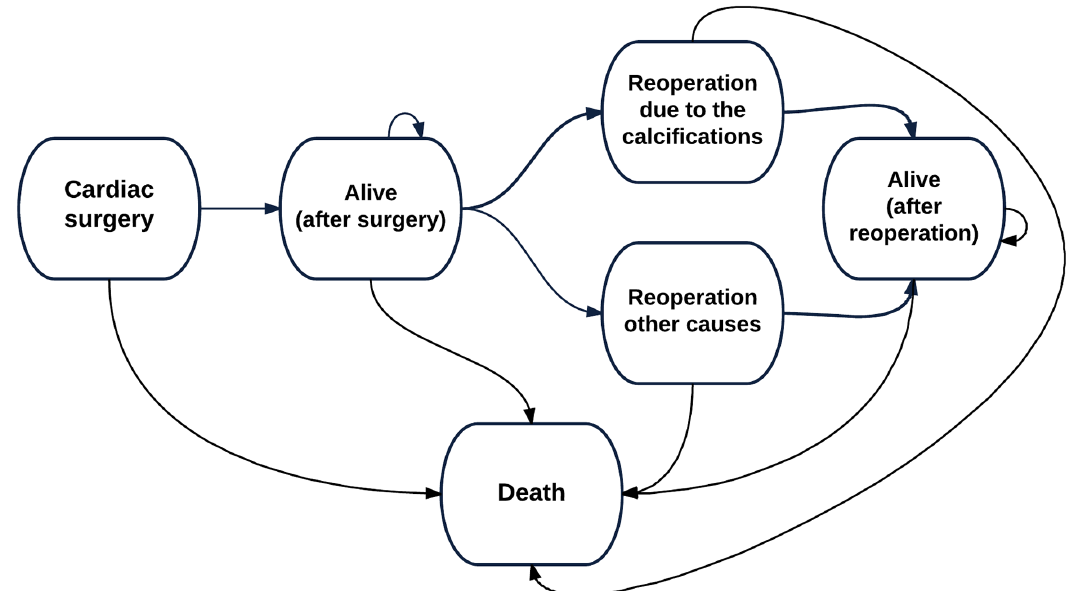
Fig 1. Health states and pathways used in the decision